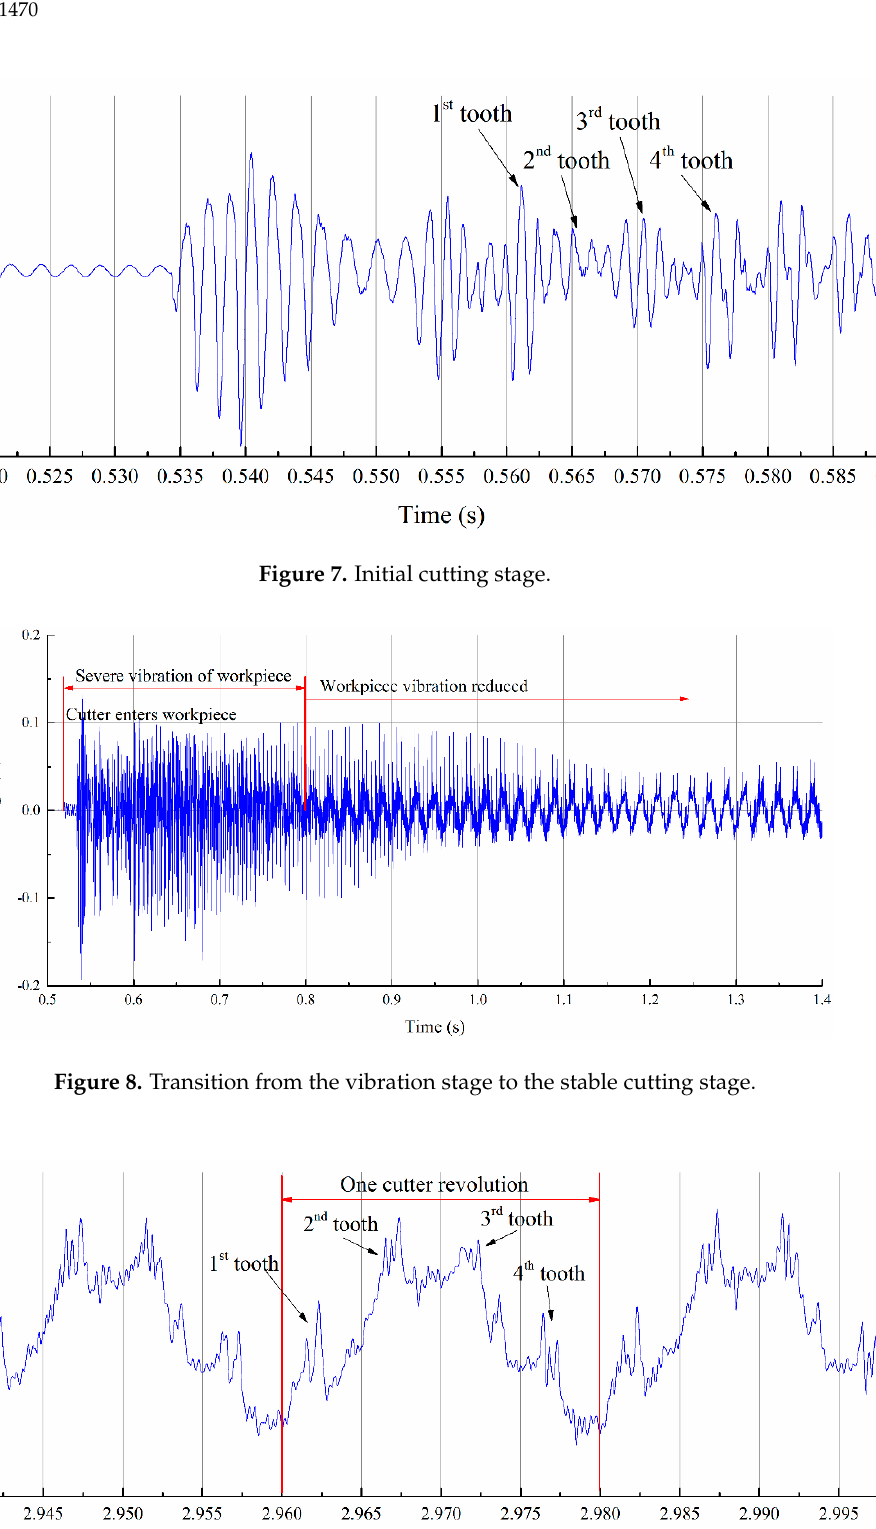
Figure 6. Output signals of the real-time monitoring system.